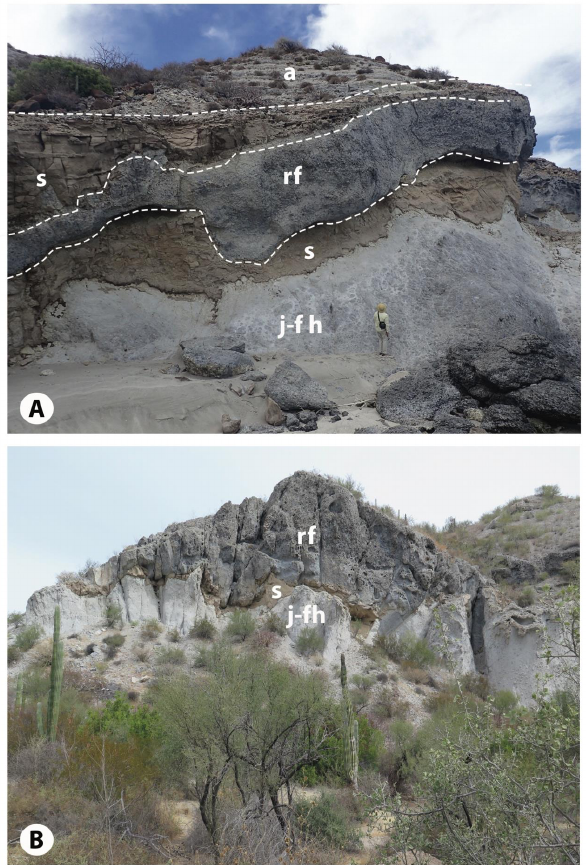
Figure 4. Stratigraphic successions at Rancho Santa Ana: ( A ) Coastal outcrop with person for scale, showing jigsaw-fitted hyaloclastite (j-fh) at the base, followed by siltstone (s), in turn baked and deformed by banded rhyolite flow (rf), overlain by more siltstone, and capped disconformably by hydromagmatic tuffs (a), ( B ) Similar sequence with cordon cacti for scale at the Santa Ana corral, showing a lesser amount of siltstone (S) squeezed between underlying hyaloclastite (j-fh) and overlying rhyolite flow (rf).